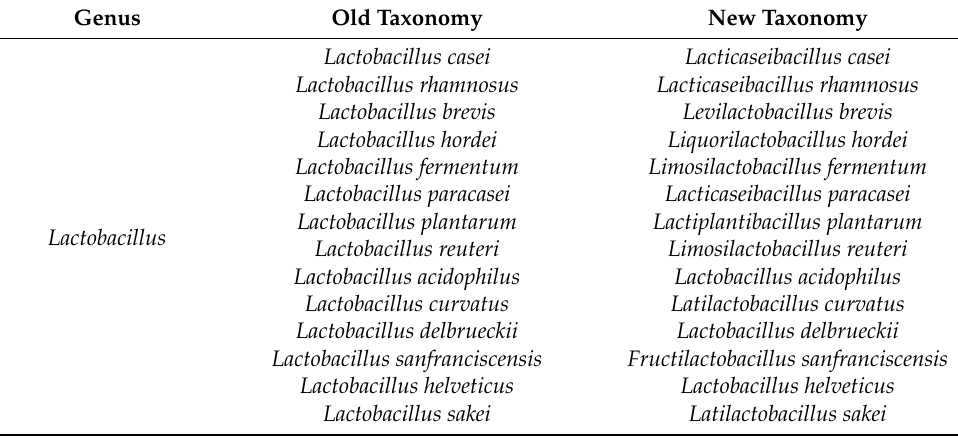
Table 1. The novel taxonomy of Lactobacillus spp.